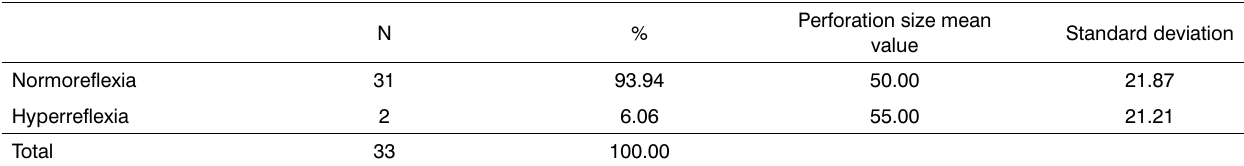
Table 4. Mean sizes of the tympanic perforations associated with the hyperreflexia.